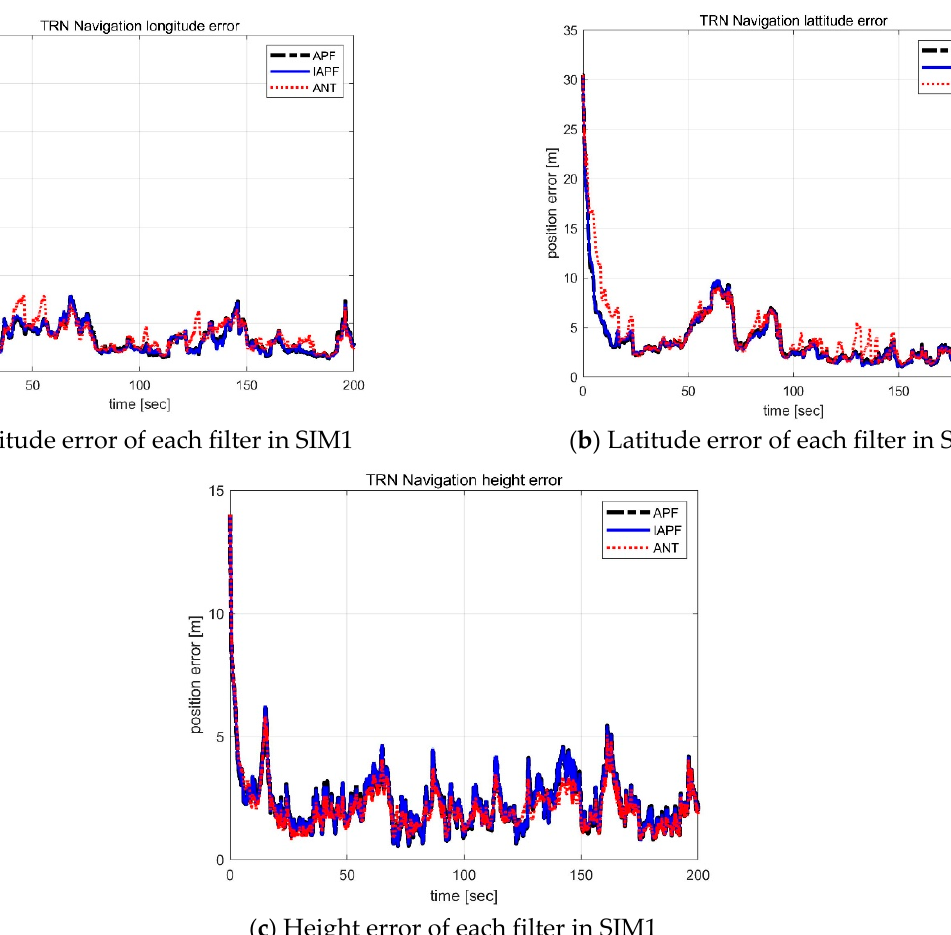
Figure 7. The position error plot of each filter in SIM1. ( a ) Longitude error of each filter in SIM1. ( b ) Latitude error of each filter in SIM1. ( c ) Height error of each filter in SIM1.